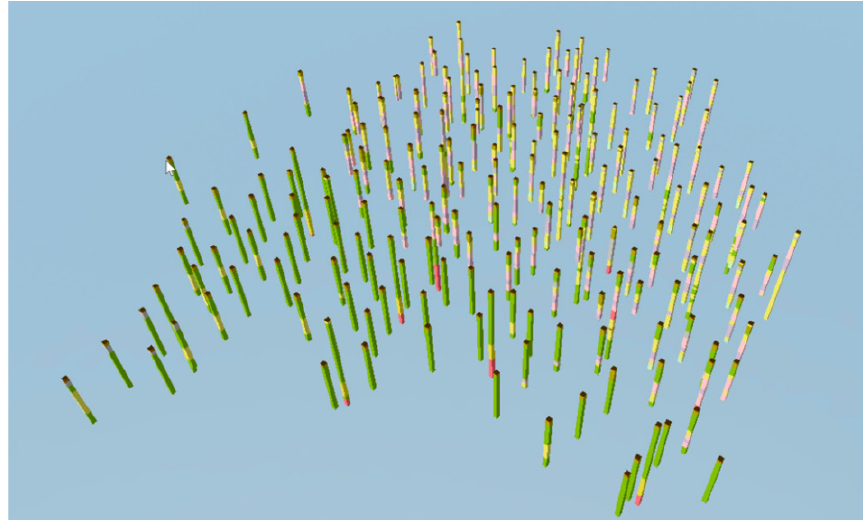
Figure 6. Interpolated drilling display diagram.